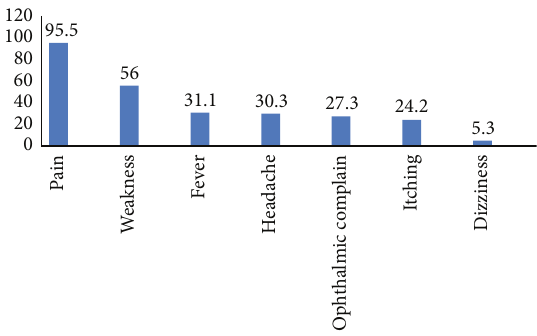
Figure 2: Prevalence of the most common symptoms